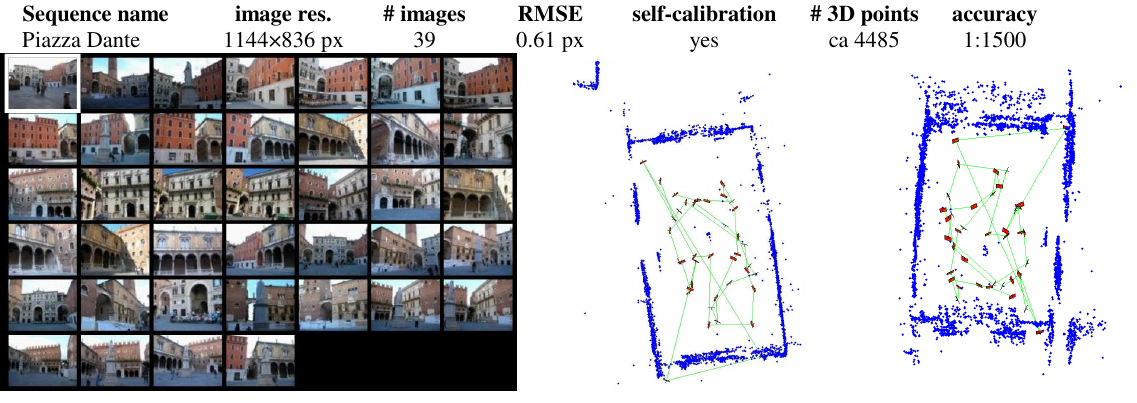
Figure 5: The camera poses for the “Piazza Dante” dataset.